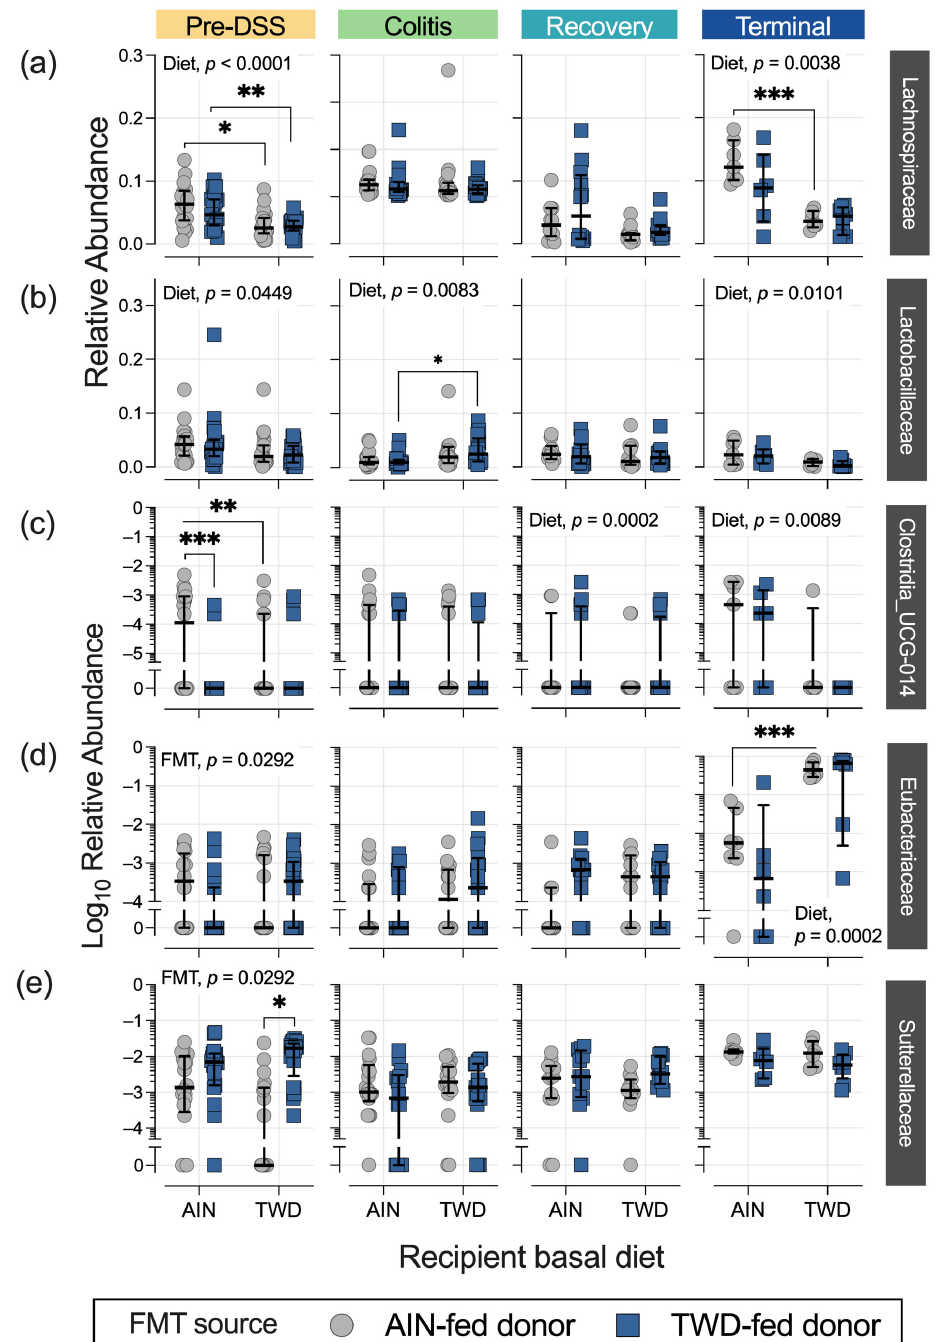
Figure 8. Relative abundance of additional bacterial families of interest at each experimental time point: ( a ) Lachnospiraceae, ( b ) Lactobacillaceae, ( c ) Clostridia_UCG_014, ( d ) Eubacteriaceae, and ( e ) Sutterellaceae. The data are shown as individual values that represent each cage (as the biological unit) with median ± interquartile range ( n = 19 to 20 cages per group at the pre-DSS time point, n = 17 to 18 cages per group at the active colitis time point, n = 12 to 13 cages per group at the recovery time point, and n = 7 to 8 cages per group at the terminal time point). For simplified visualization, this plot shows only the statistical results as FDR-corrected p-values for significant main effects or the post hoc comparisons of FMT from the AIN-fed or TWD-fed donors: *, p < 0.05; **, p < 0.01; and ***, p < 0.001, as outlined in the Materials and Methods section. The complete results of all metagenomeSeq statistical analyses, including pairwise comparisons by recipient basal diet and across time points, are provided in Supplementary File S2.